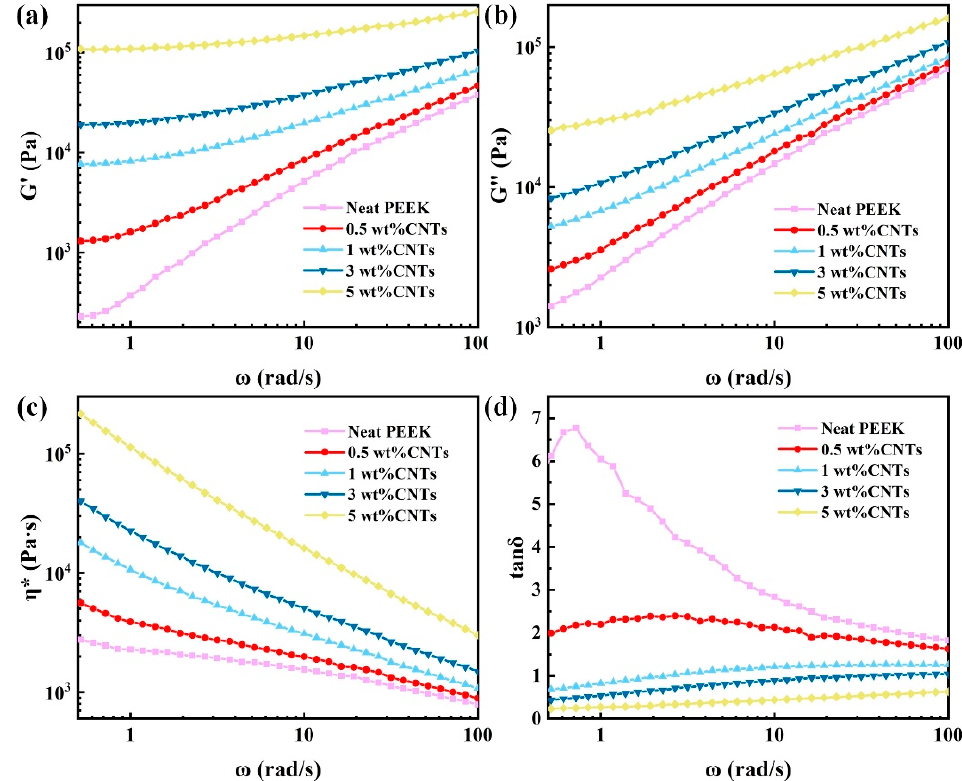
Figure 2. The viscoelastic behavior of PEEK/CNTs composites with different CNTs content: ( a ) the storage modulus (G’); ( b ) loss modulus (G’’); ( c ) complex viscosity ( η *); and ( d ) loss factor (tan δ ).